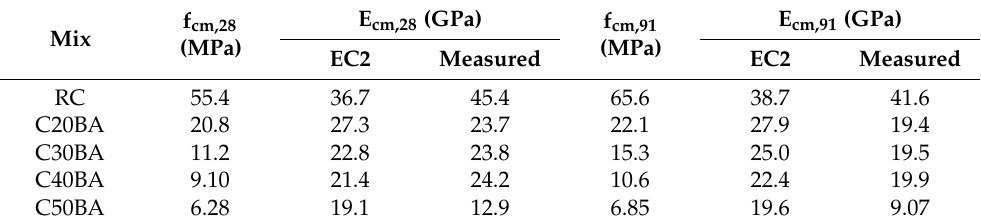
Table 7. E cm vs. f cm according to Eurocode 2 [39] at 28 and 91 days.